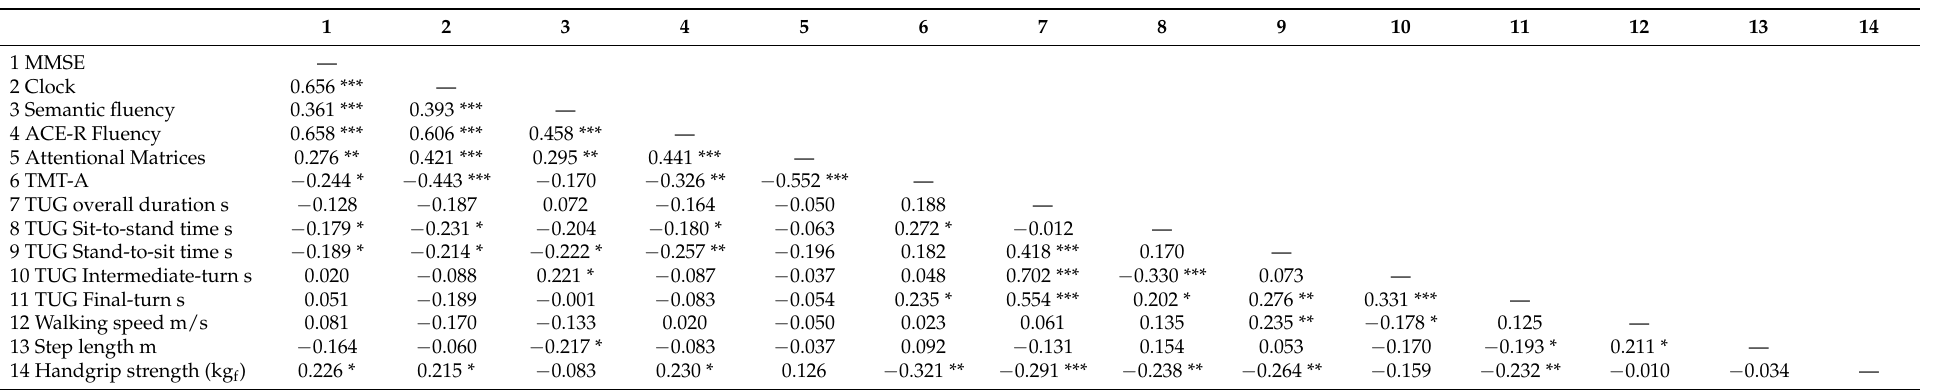
Table 1. Zero-order correlations among global cognitive efficiency (i.e., MMSE), clock-drawing (i.e., clock), semantic fluency, ACE-R Verbal Fluency subtest (i.e., ACE- R Fluency), speed of processing and number sequencing (i.e., TMT-A), selective and divided attention (i.e., Attentional Matrices), Timed-Up-and-Go (i.e., TUG overall duration, TUG-Sit-to-stand, TUG-Stand-to-sit, TUG-Intermediate turn, TUG-Final turn), walking speed, step length and handgrip strength